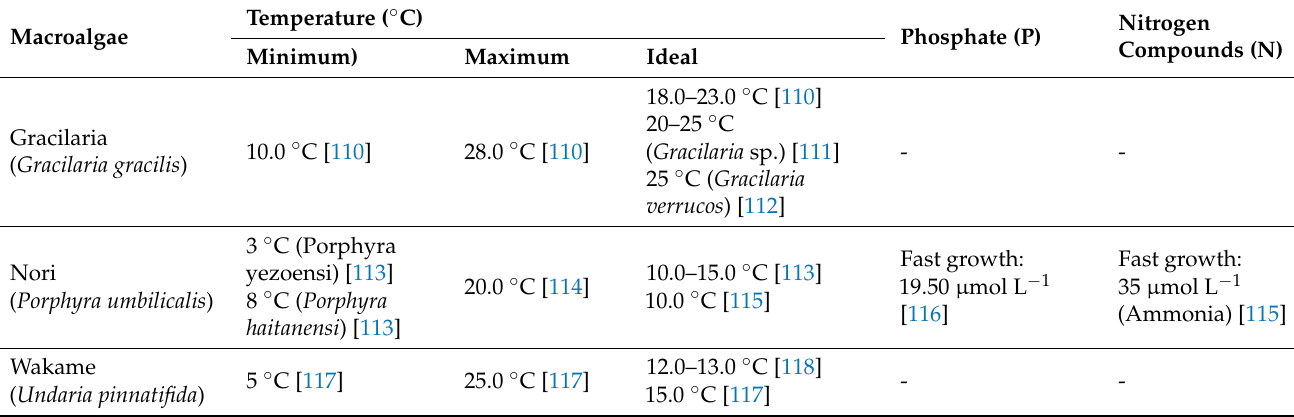
Table 5. Minimum, maximum, and optimal temperature ( ◦ C), phosphate ( µ mol L − 1 ) and nitro- gen ( µ mol L − 1 ) for the production of the selected potential macroalgae species to be produced in aquaculture in Portugal.